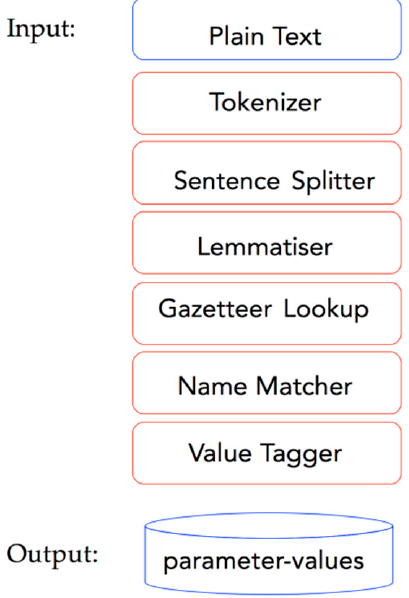
Figure 3. System workflow for text processing steps (in red).